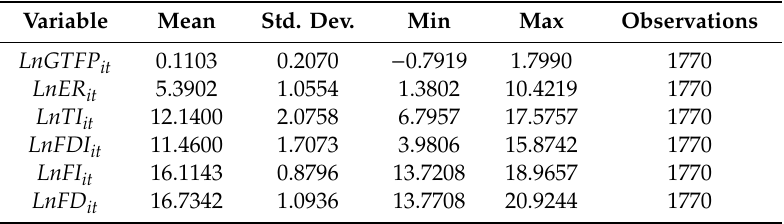
Table 1. Statistical description of all sample